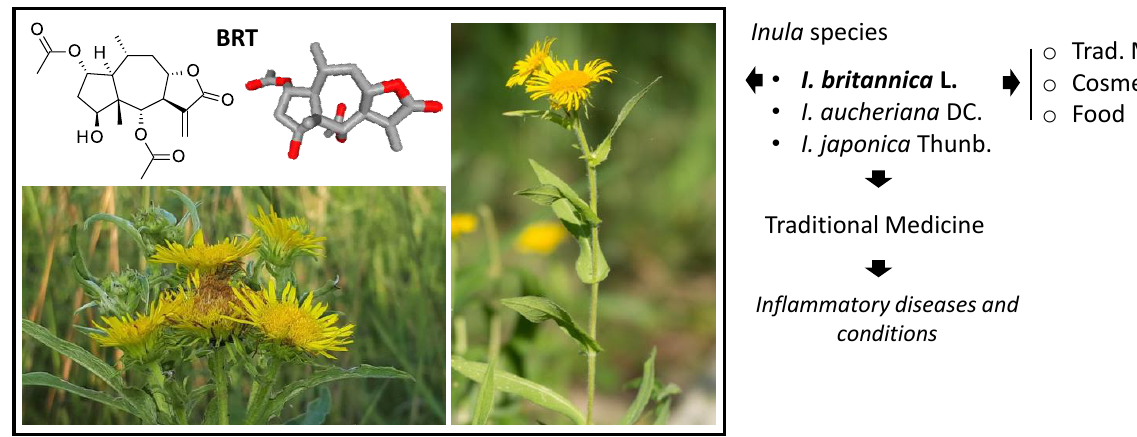
Figure 2. Chemical structure and conformation of britannin (BRT), isolated from the plant Inula britannica L. (photos accessi- ble from https://identify.plantnet.org/fr/weurope/species/Inula%20britannica%20L./data, accessed on 25 September 2021). Each plant produces several yellow ray flowers, positioned on a long flower stalk. BRT can be isolated from other Inula species, such as I. japonica , I. aucheriana , and I. oculus-christi